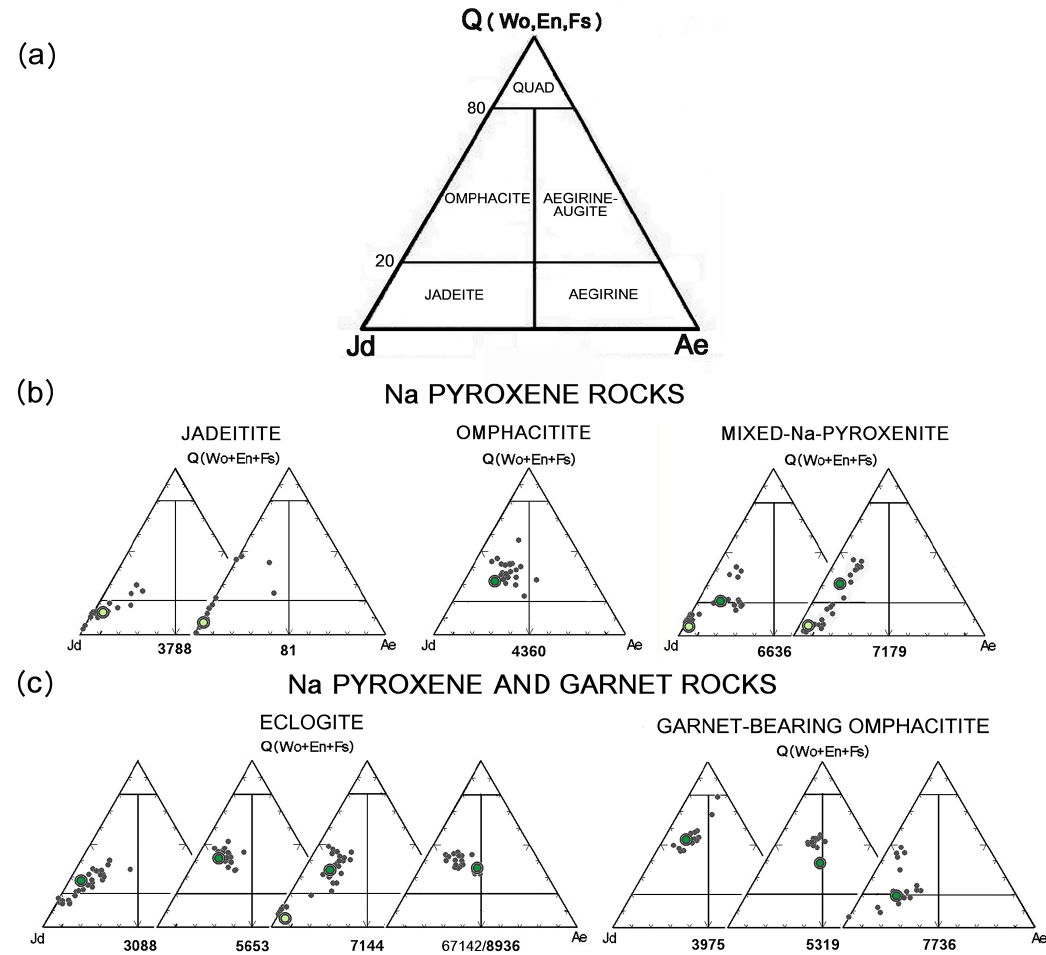
Figure 5. (a) Pyroxene classification diagram proposed by Morimoto et al. (1988), (a) reporting the compositional variation in clinopyroxenes in the Chiomonte tools, (b) Na pyroxene rocks (five specimens), and (c) Na pyroxene and garnet rocks (seven specimens). The bigger dots indicate the average composition of jadeite (light green) and omphacite (dark green) solid solutions, estimated by plotting the d hkl values of the three characteristic clinopyroxenes reflections ( − 221, 310 and 002) on the compositional grid of Giustetto et al.